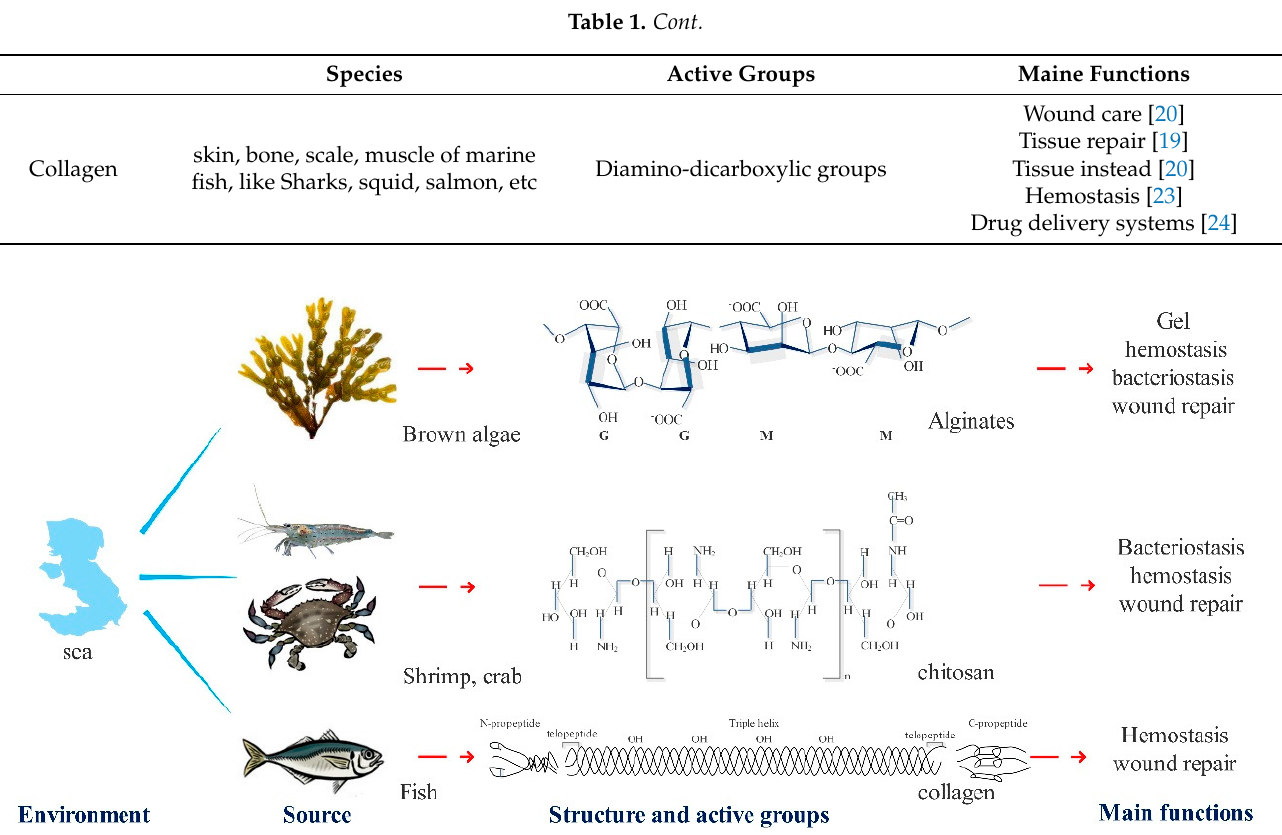
Figure 1. Unique structures, active groups, main functions, and source of three polymers from the sea. Table 1. Main active groups, functions, and sources of three polymers.